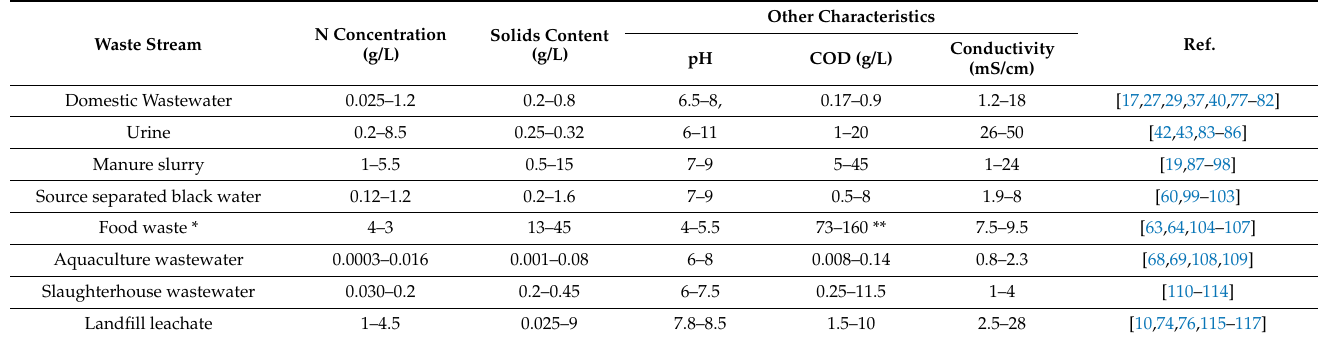
Table 2. Literature of examples of waste streams for nitrogen